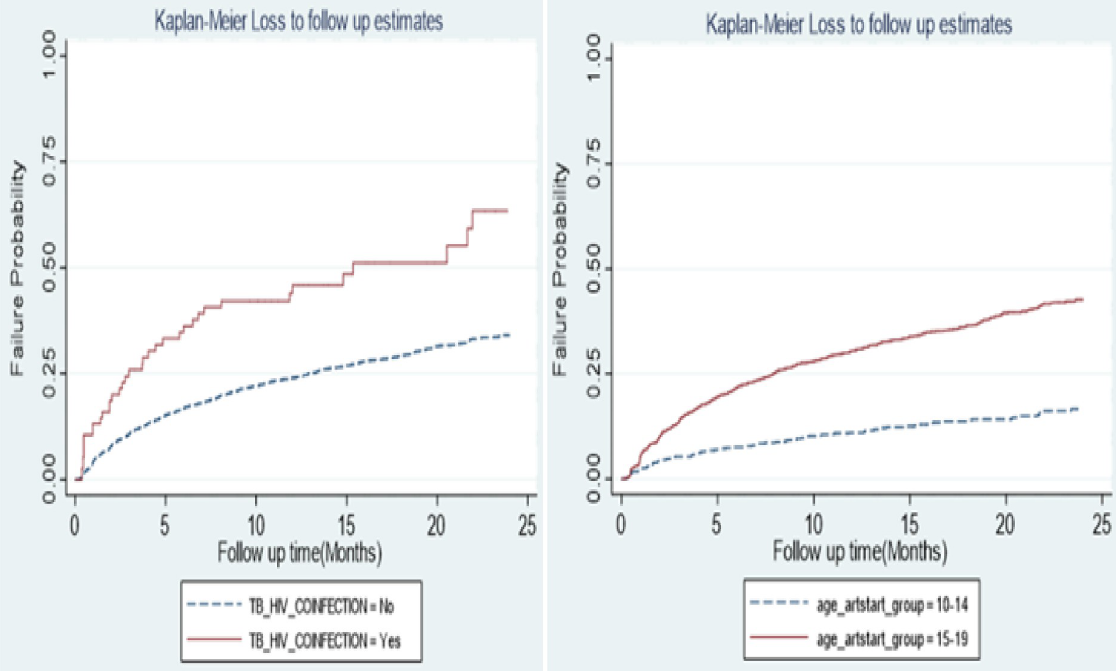
Fig 2. Failure probability among adolescents in HIV/TB Co-infection status and age